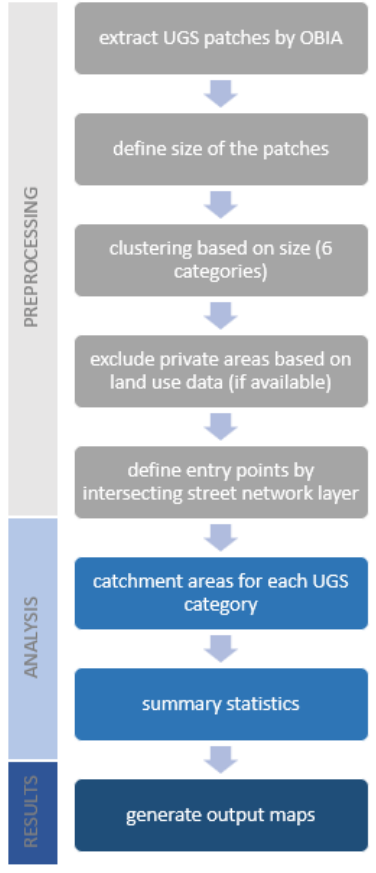
Figure 4. Proposed workflow to analyse UGS accessibility using EO data and OSM street